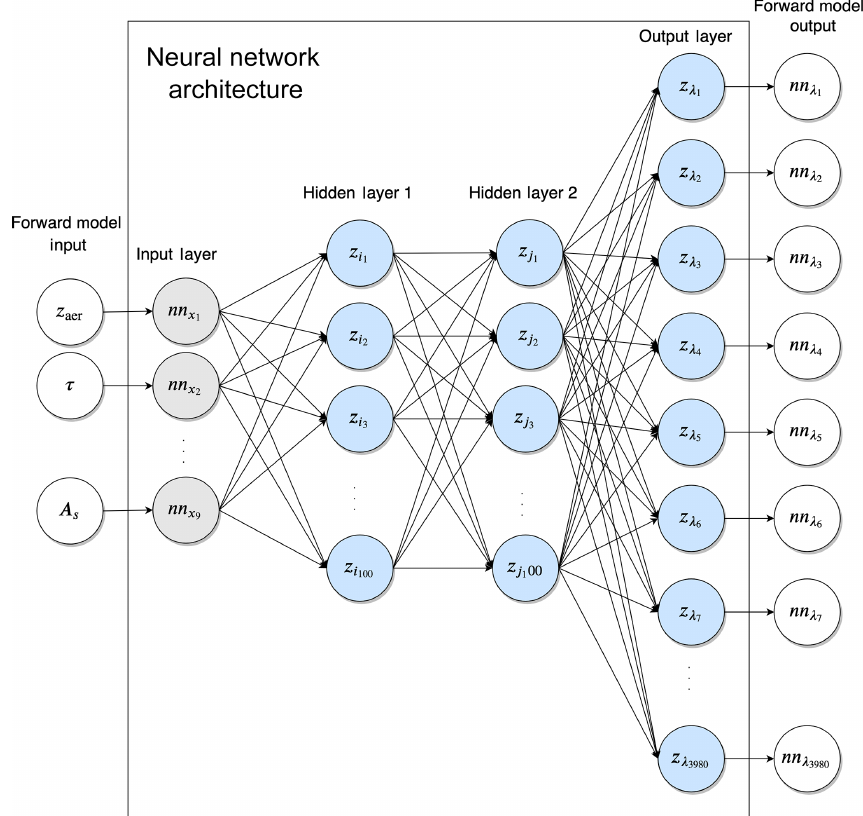
Figure 3. Schematic of each of the three neural networks in NN. There are two hidden layers, each containing 100 nodes. z represents inputs for each of the nodes, whereas nn represents the inputs and outputs of the neural